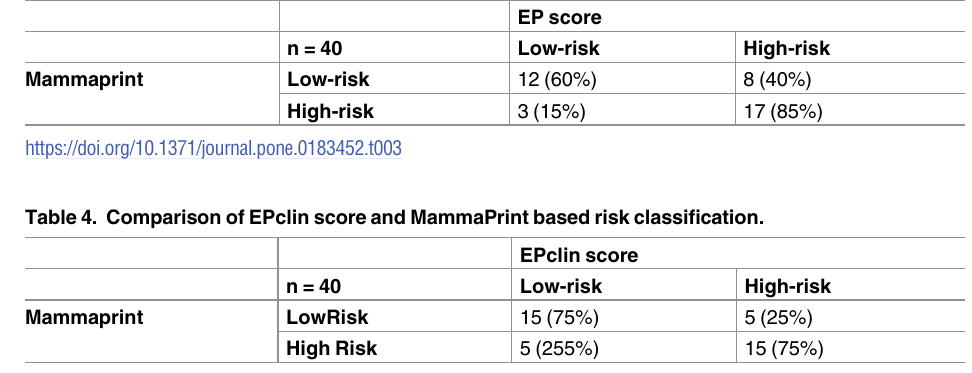
Table 3. Comparison of EPscore and MammaPrint based risk classification.